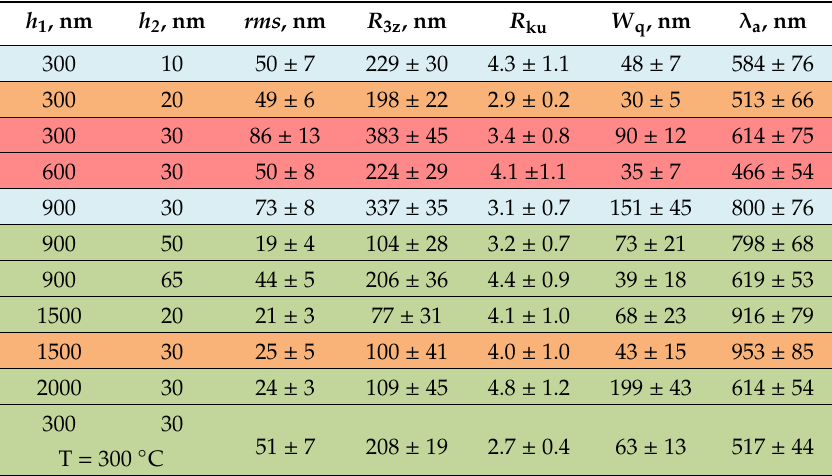
Table 2. Morphology